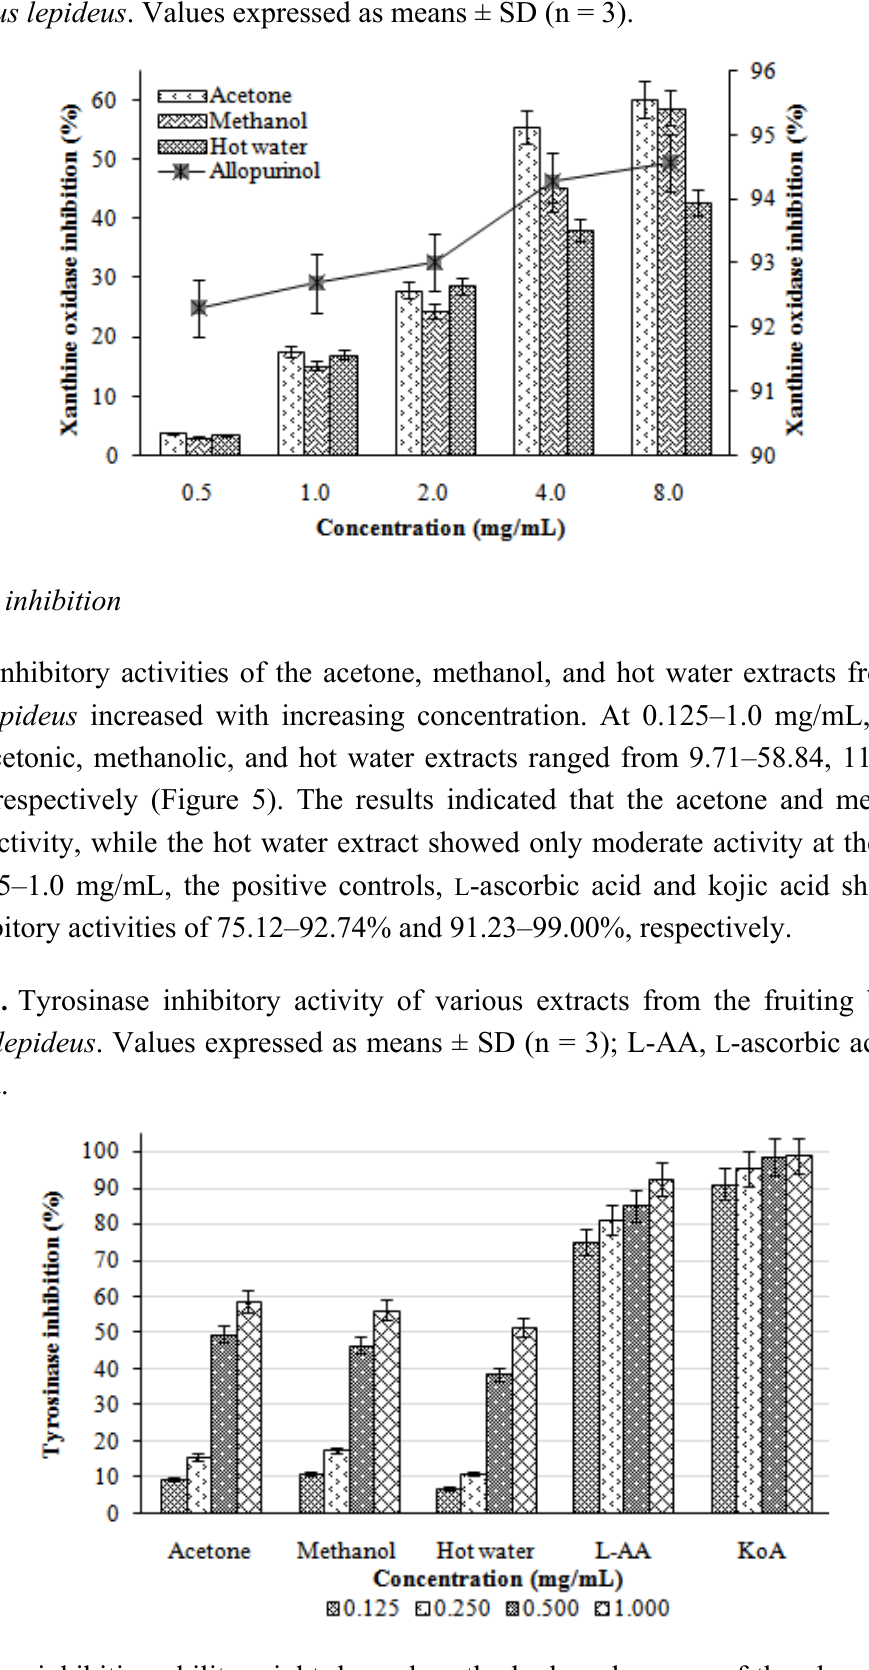
Figure 4. Xanthine oxidase inhibitory activity of various extracts from the fruiting bodies of Lentinus lepideus . Values expressed as means ± SD (n = 3).